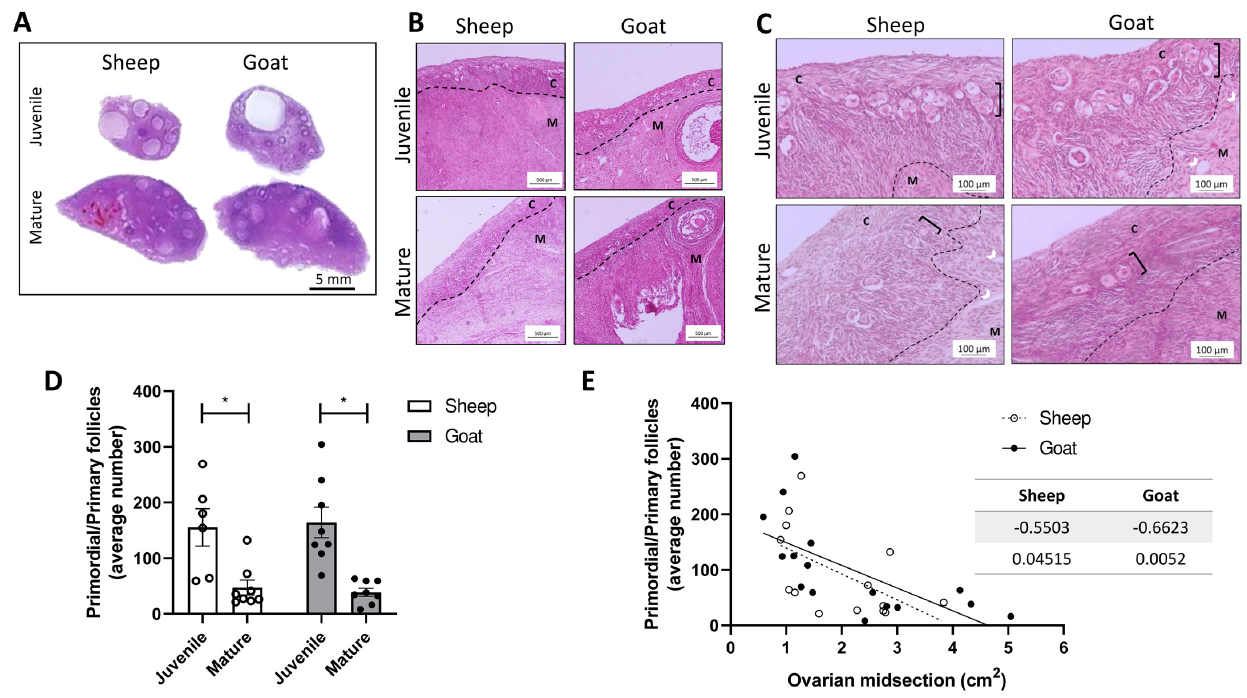
Figure 1. Sheep and goat ovarian structure and follicle pool. ( A )—Representative ovarian midsections from juvenile and mature sheep and goats stained with haematoxylin and eosin. ( B , C )—Representative ovarian midsections of juvenile and sheep and goats showing the distribution of primary and primor- dial follicles (right brackets) inserted in the ovarian cortex (letter C). Beneath the ovarian cortex, the ovarian medulla (letter M) with blood vessels is visible (arrowheads). Dash line separates the ovarian cortex from the medulla. ( D )—Average number of primordial/primary follicles per animal and age group. A significant decrease in follicle pool was observed in mature sheep and goats (* p < 0.05). ( E )—Negative correlation between the number of primordial/primary follicles and the area of ovarian midsection ( p <